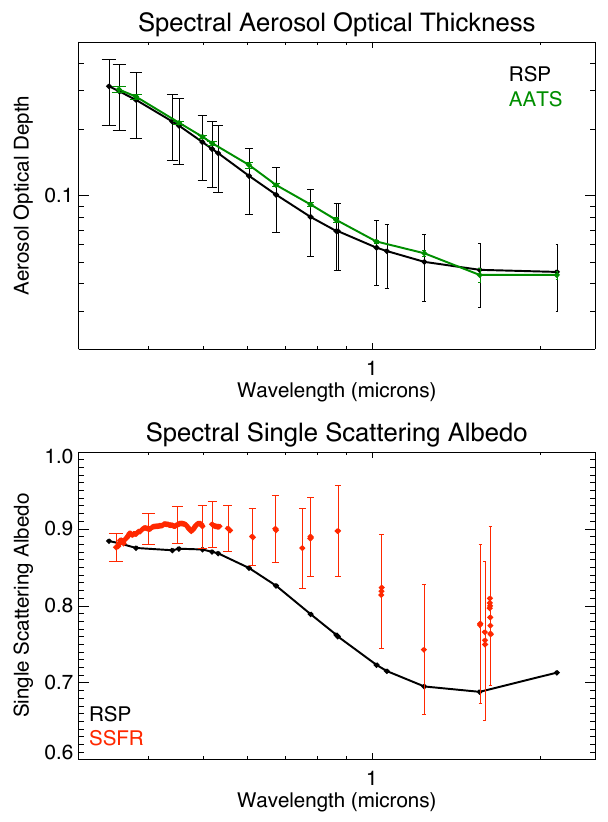
Fig. 9. The topmost panel in this figure is the spectral dependence of retrieved total aerosol optical thickness (black line) and the AATS observation (green line) at an altitude of 480m during the down- ward spiral indicated in Fig. 2. The bottom panel is the spectral dependence of the total single scattering albedo. The black line is the RSP retrieved single scattering albedo, where the large error bars are omitted for clarity (they would fill the entire range of val- ues in the plot). Red indicates SSFR observations as described in Bergstrom et al.